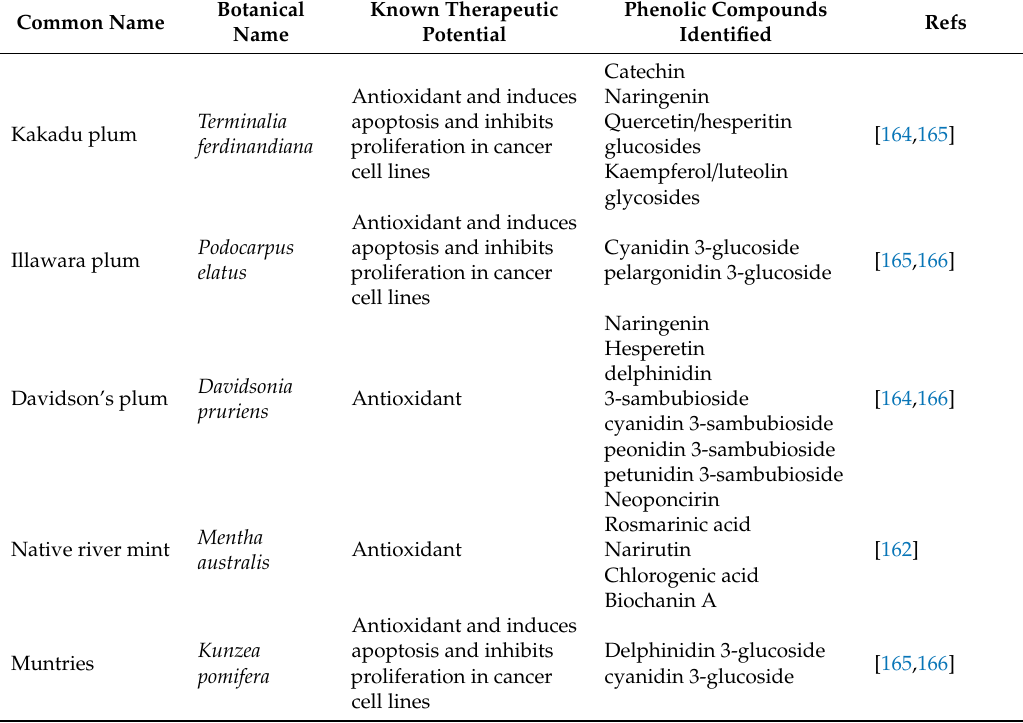
Table 1. Phenolic compounds from native Australian